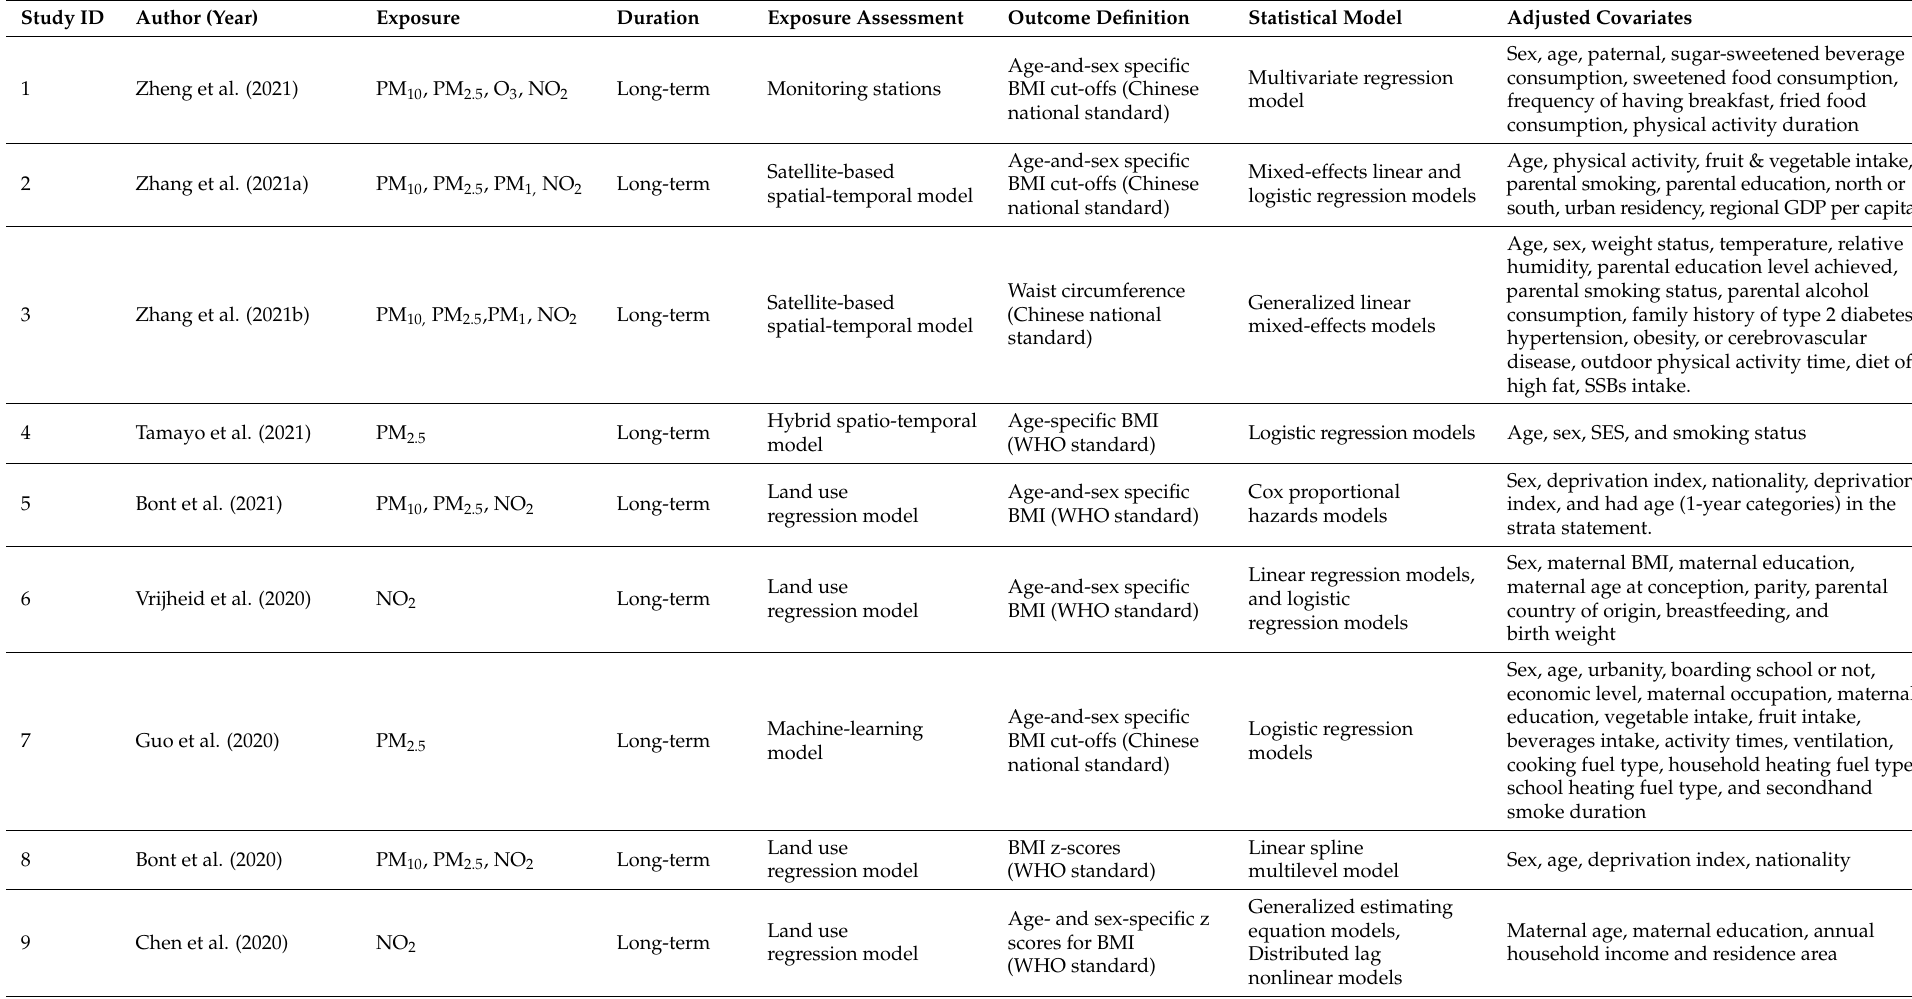
Table 2. Exposure, outcome, and statistical information of the 15 included studies on the association between air pollution and childhood